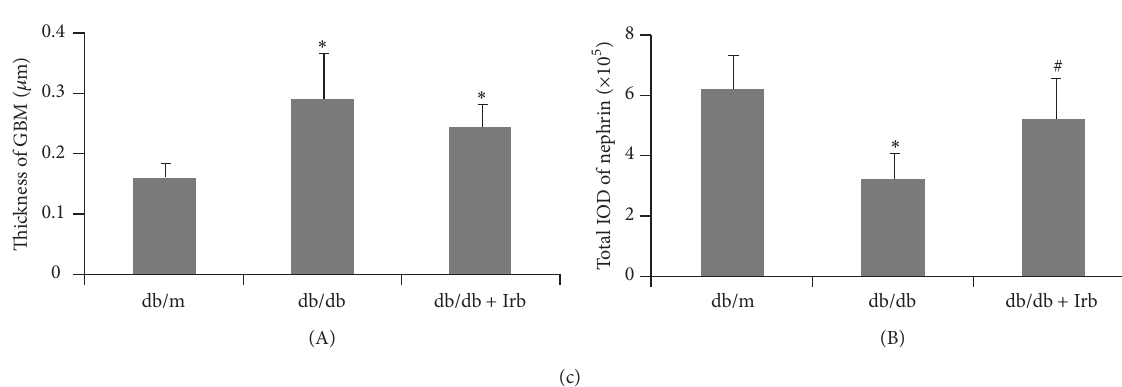
Figure 3: Irb alleviated diabetes-induced podocyte injury and the thickening of the GBM. (a) Representative fields of podocyte foot processes under TEM (scale bars: 2 𝜇 m; red arrow indicates podocyte foot process effacement). (b) Representative fields of nephrin, as labeled by immunohistochemical staining (scale bars: 50 𝜇 m). (c) Quantification of the GBM thickness (A) and immunohistochemical staining (B). The bars in panel (c) show the mean expression in arbitrary units (error bars, SD). ∗ 𝑃 < 0.05 compared with db/m; # 𝑃 < 0.05 compared with db/db, 𝑡 -test.